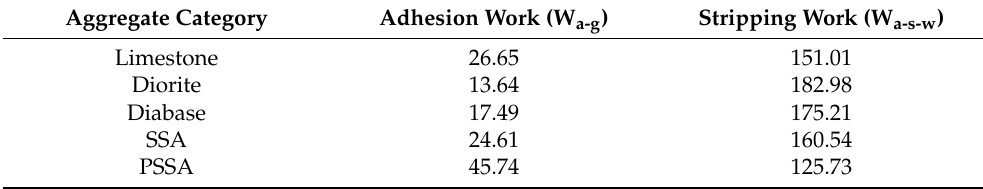
Table 7. Adhesion work and stripping work of various aggregates and bitumen (mJ/m 2 ).